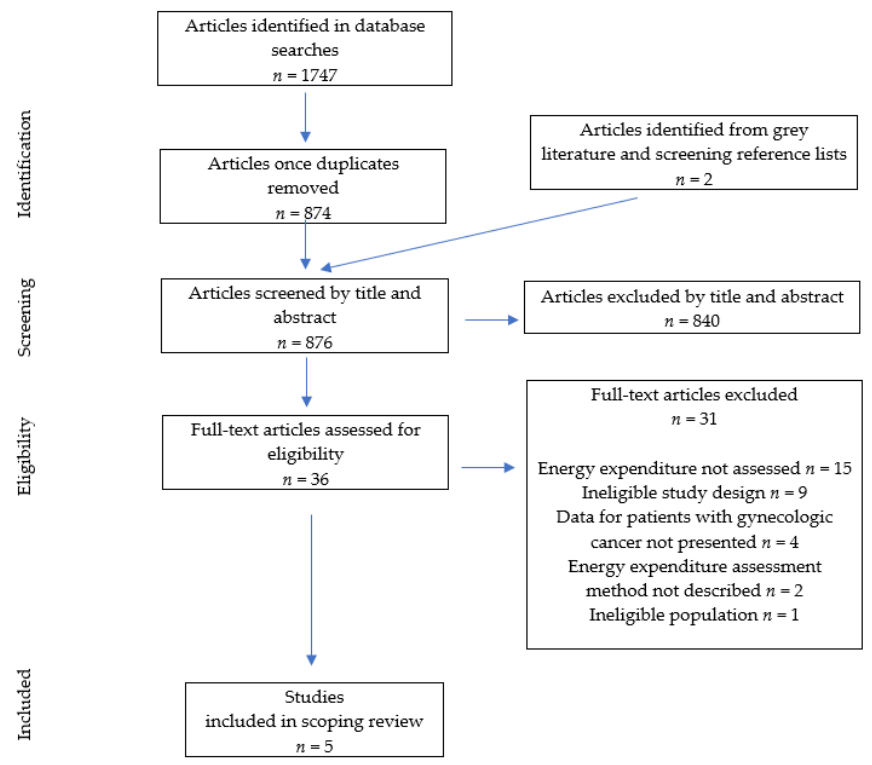
Figure 2. Flow diagram describing the inclusion process of studies investigating energy metabolism in gynecological